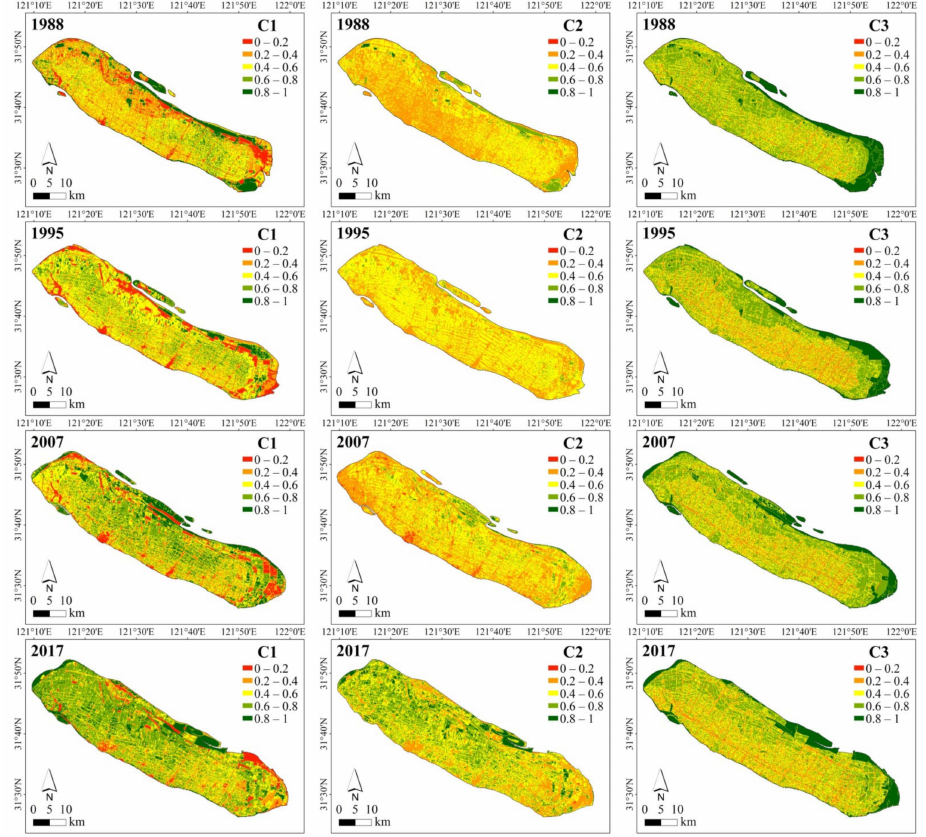
Figure 6. Spatiotemporal characteristics of the three components in the four years: C1: vegetation component; C2: soil component; C3: landscape